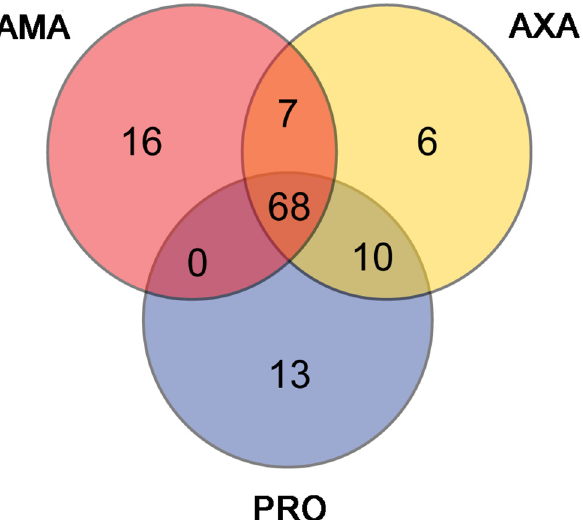
Fig 6. The majority of highly expressed transcripts are shared between AMA, AXA and PRO. The Venn diagram shows for each cell type the 91 transcripts comprising the top percentile of FPKM values and indicates the extent of overlap between the three